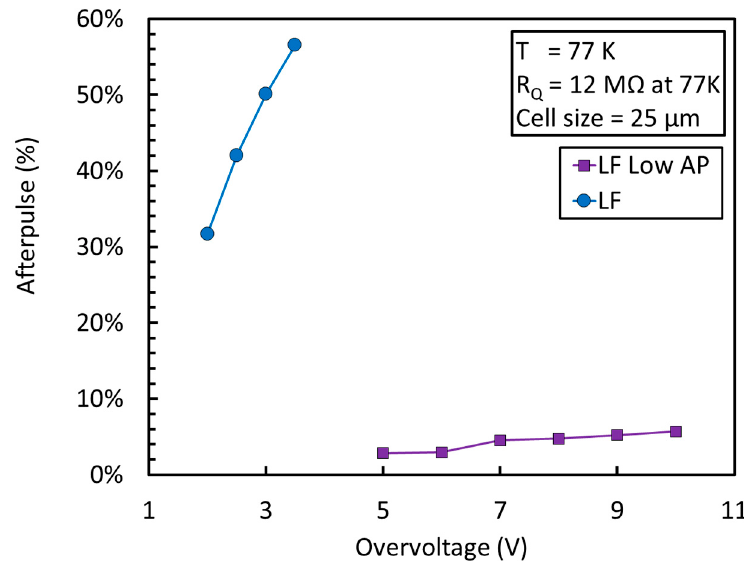
Figure 20. AP as a function of the OV at 77 K for the NUV-HD-LF and NUV-HD-LF-LowAP SiPMs.